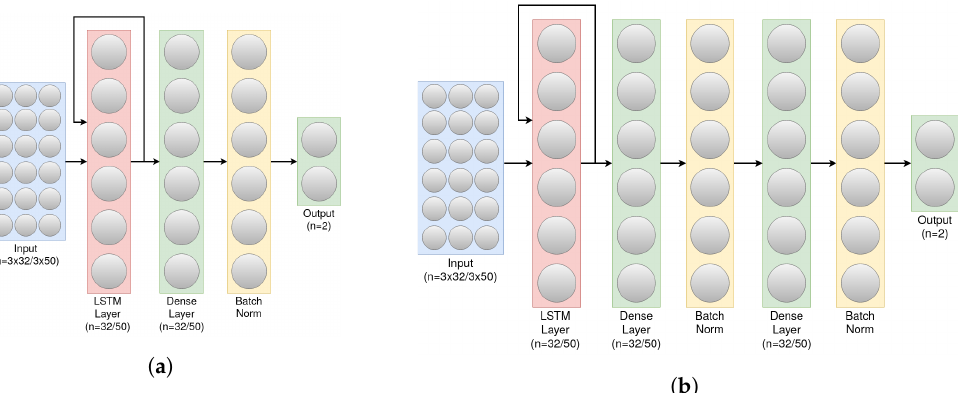
Figure 4. ( a ) Overview of the old classifier’s architecture. ( b ) Overview of an improved LSTM